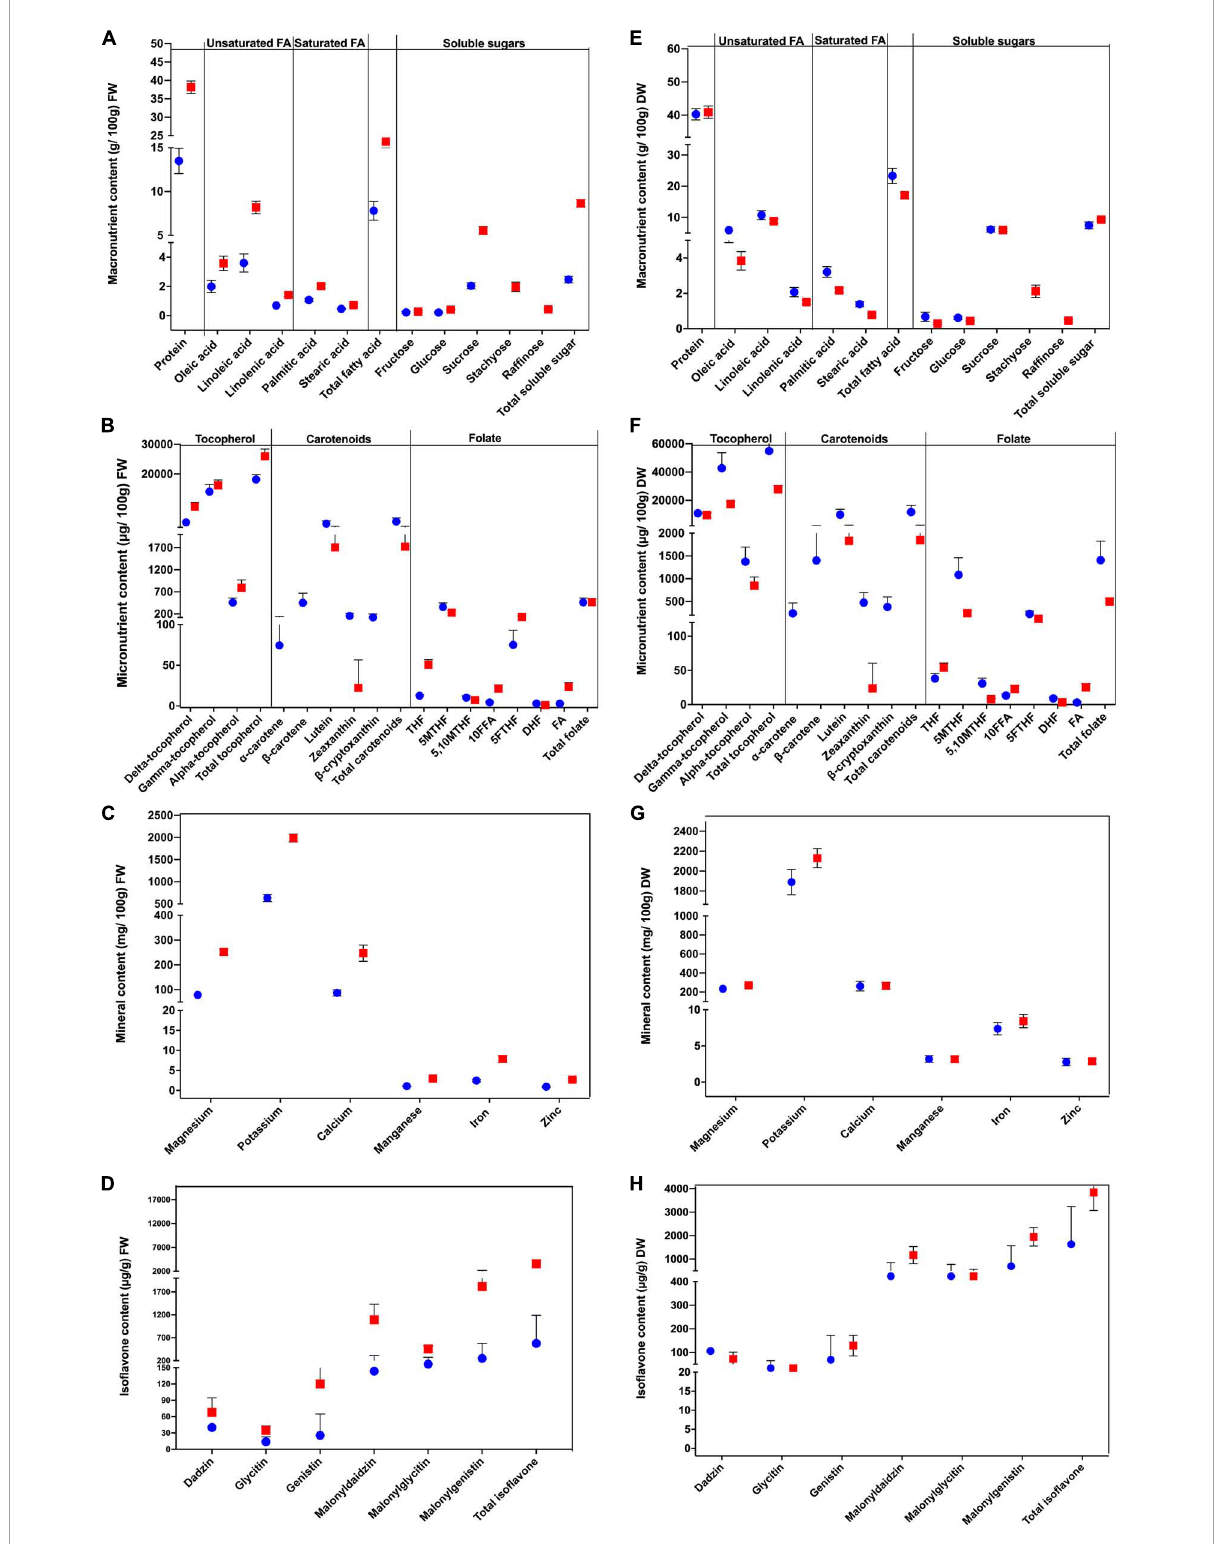
FIGURE3 Variations in the nutritional composition of maodou (blue) and mature soybean (red). (A) Macronutrient, (B) micronutrient, (C) mineral, and (D) isoflavone contents calculated on a fresh weight basis (FW) (left panel). (E) Macronutrient, (F) micronutrient, (G) mineral, and (H) isoflavone contents calculated on a dry weight basis (DW) (right